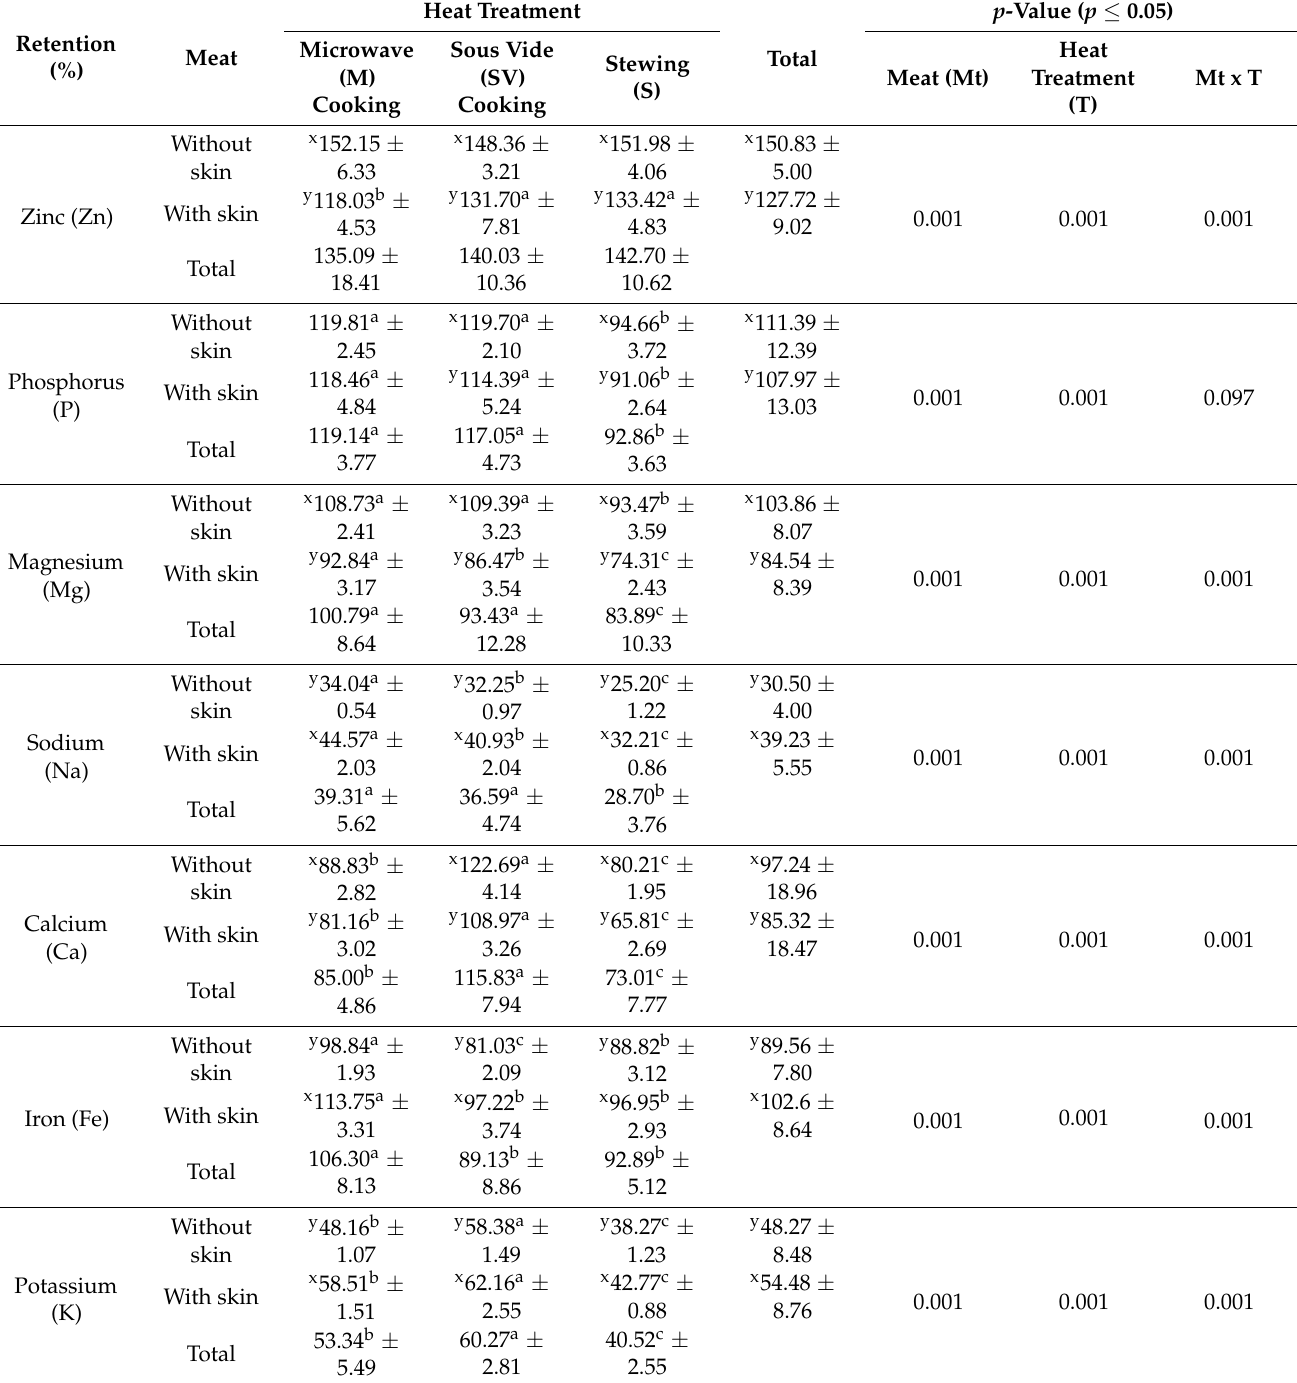
Table 4. Mineral retention coefficients (%) in cooked goose meat (n = 6 breast muscles with skin and n = 6 without skin for each kind of heat